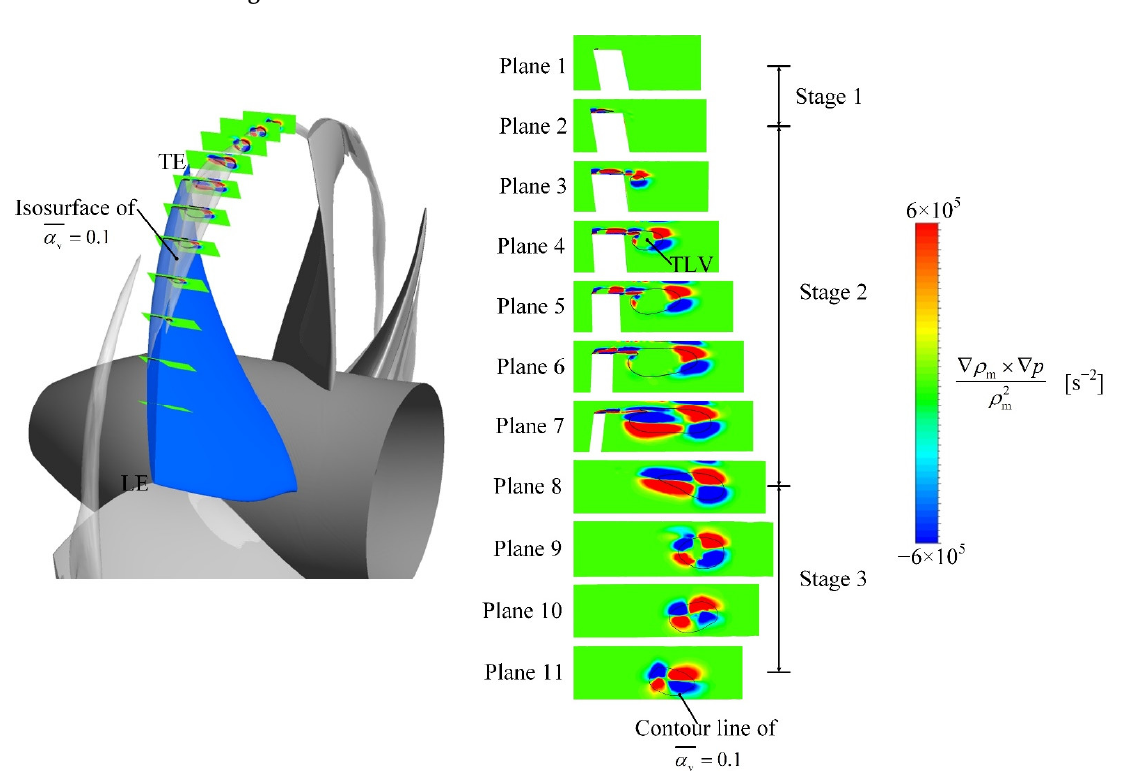
Figure 10. Vortex baroclinic-torque term.